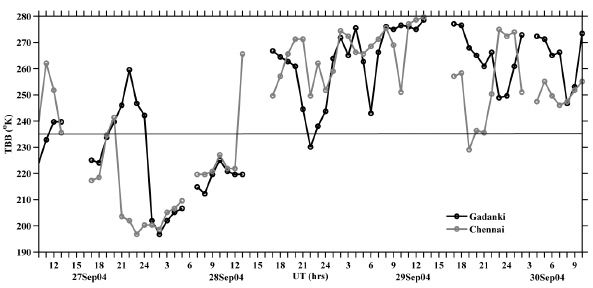
Figure 1. Hourly Cloud Top Brightness Temperature (TBB, in K) over Gadanki (black) and 628 Fig. 1. Hourly cloud top brightness temperature (TBB, in K) over Gadanki (black) and Chennai (gray) for 27–30 September 2004. Chennai (gray) for 27-30 September 2004. The line at the 235 K indicates the threshold value of 629 The line at 235K indicates the threshold value of deep convective deep convective event. 630